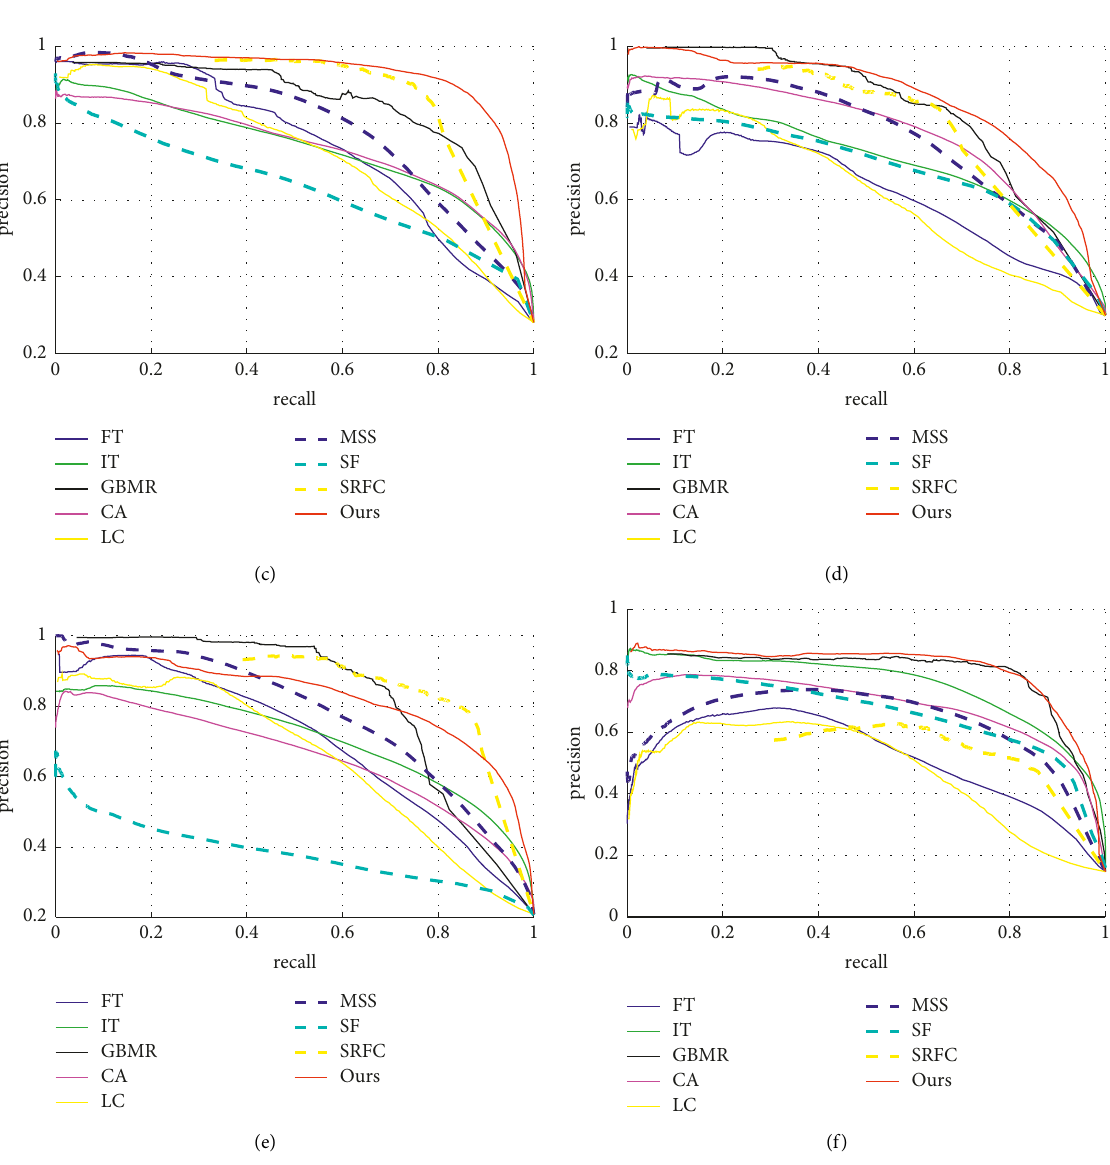
Figure 6: PR curves over different datasets. (a) MASK10K; (b) SOD; (c) DUTS; (d) ECSSD; (e) HKU_IS; and (f)